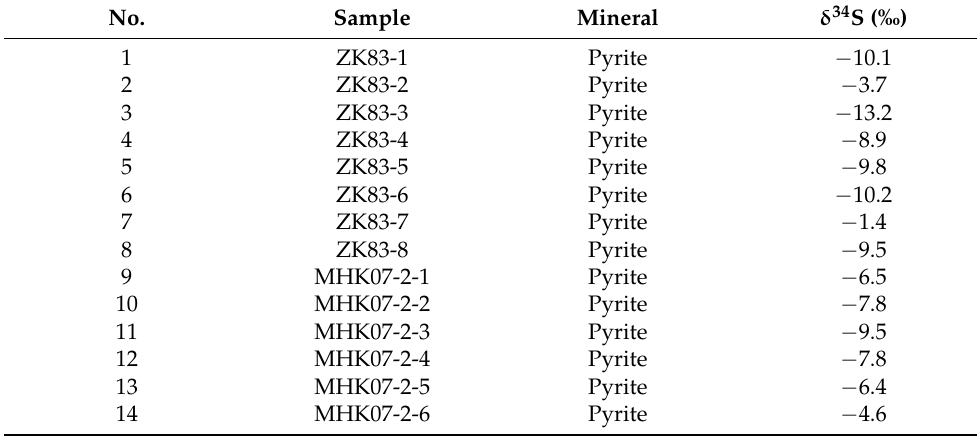
Figure 6. Box diagram of trace element concentrations and ratios for the syn-mineralization pyrite from the Mianhuakeng U deposit. Concentrations are in ppm. Table 3. The δ 34 S values for syn-mineralization pyrite from the Mianhuakeng U deposit.